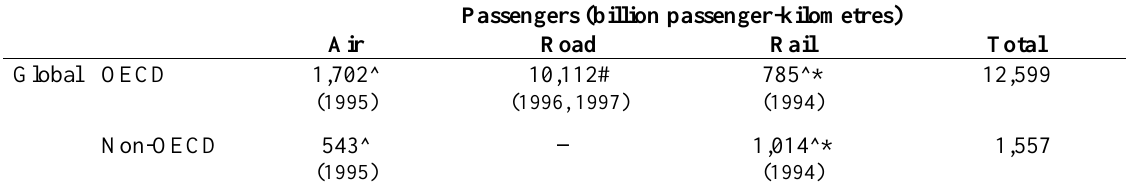
Table 14. Data for passenger transport